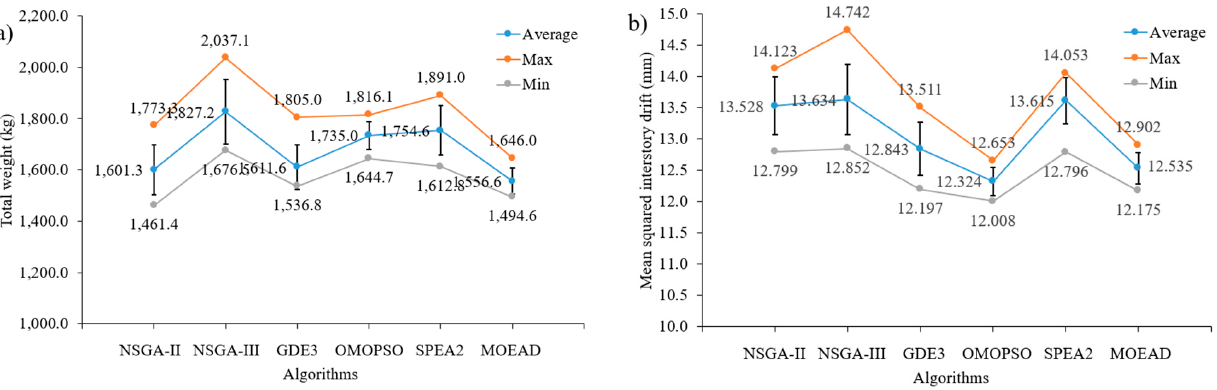
Figure 16. Spread illustration of the optimal solutions in the 47-bar power line truss regarding the ( a ) first objective; ( b ) second